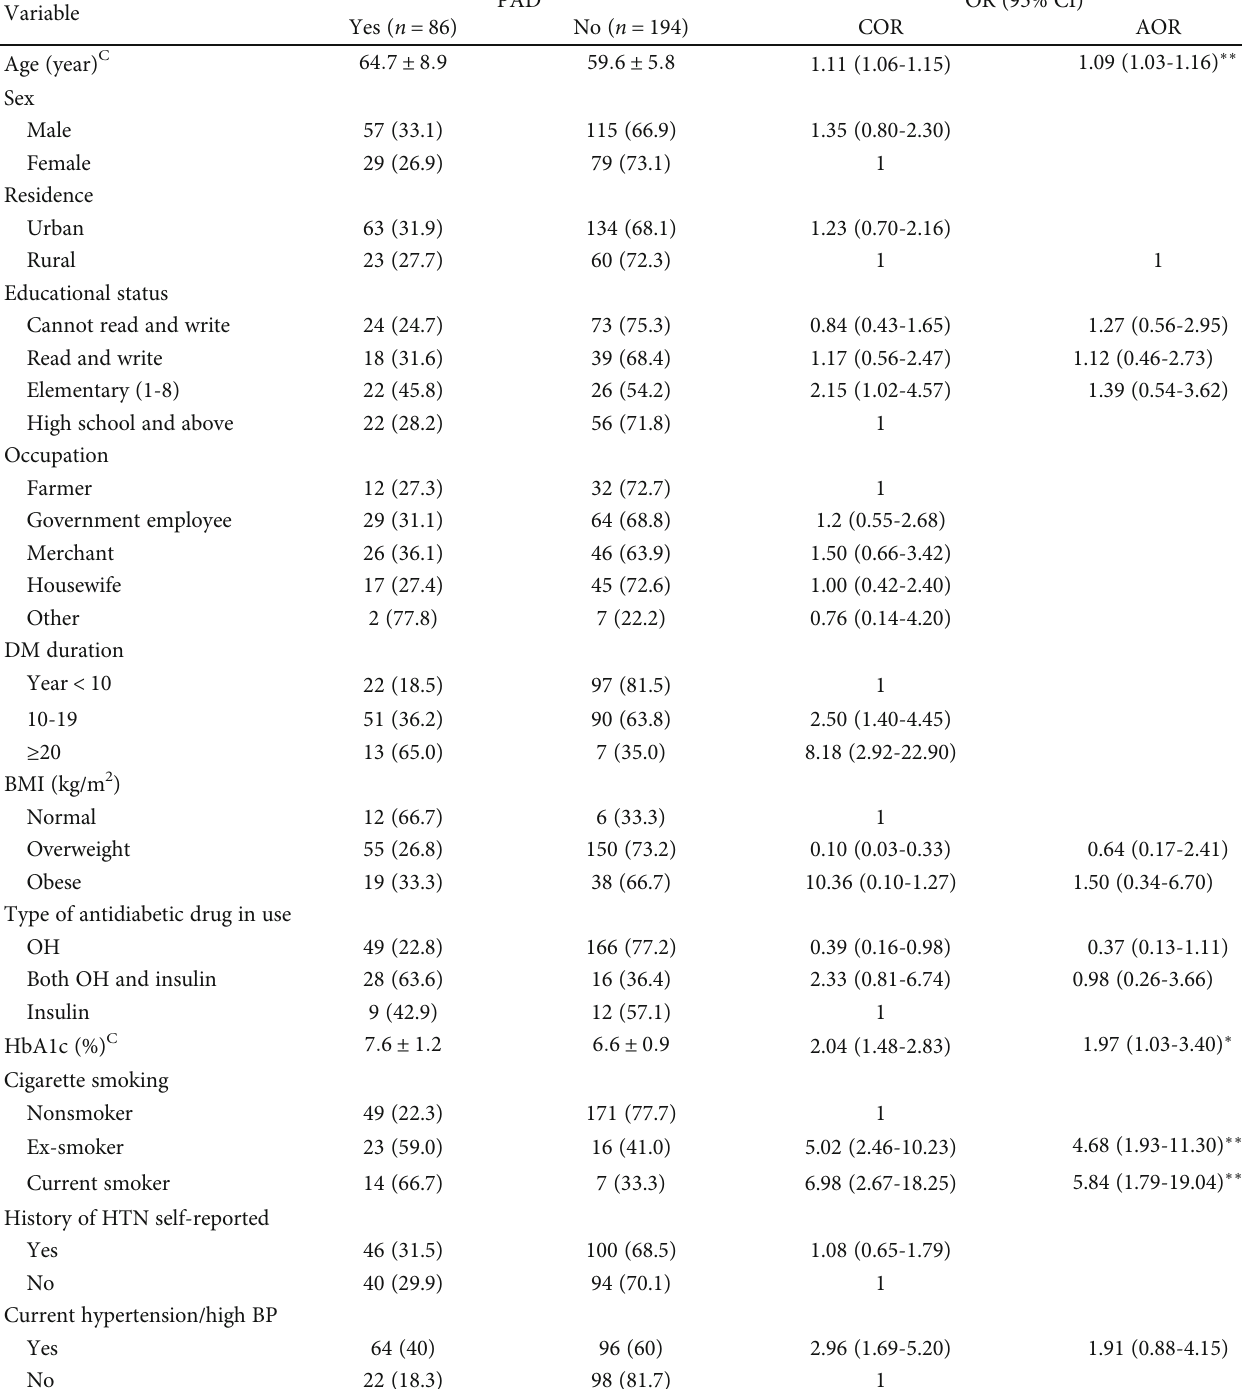
Table 3: Factors associated with PAD among type 2 diabetes mellitus patients in bivariable and multivariable logistic regression analyses, Debre Tabor, Northwest Ethiopia,